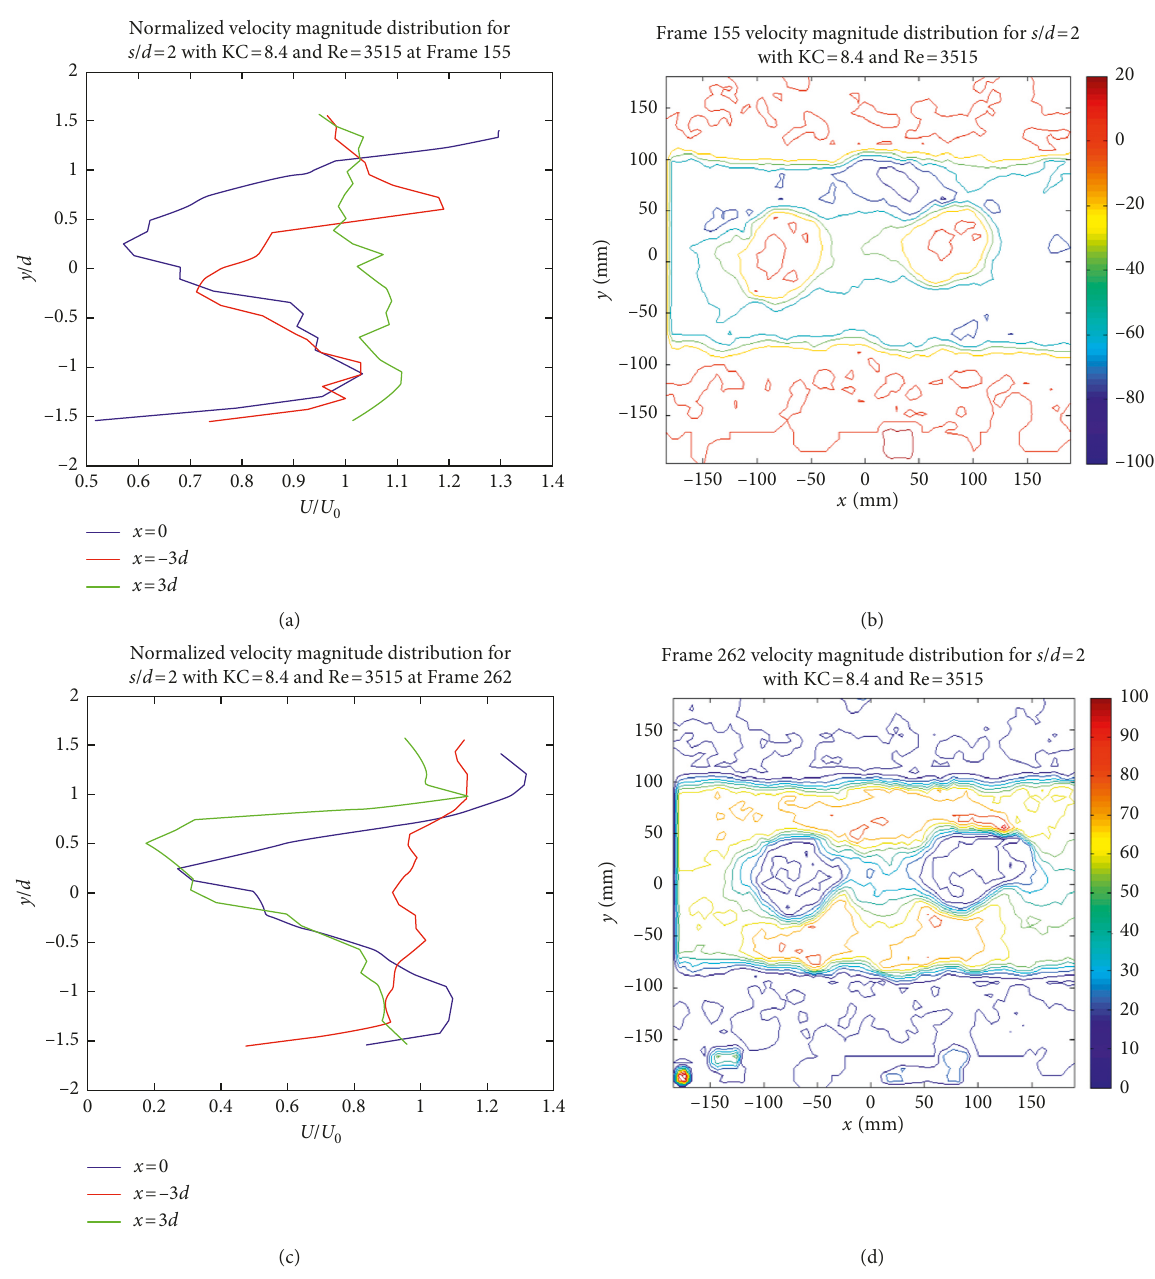
Figure 8: Normalized velocity and velocity contour when s/d velocity magnitude contour at Frame 155; (c) normalized velocity at Frame 262; (d) velocity magnitude contour at Frame